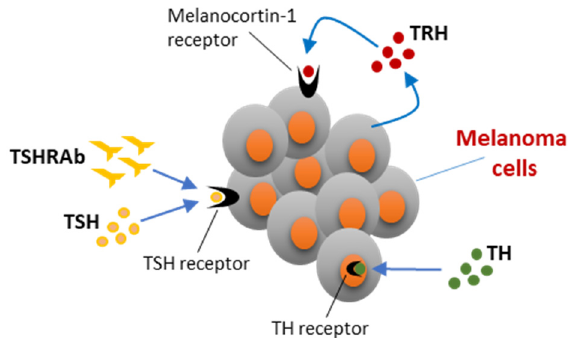
Figure 1. Schematic representation of the action of the different hormonal players of the hypothalamic–pituitary–thyroid axis on melanoma cells. TRH, thyrotropin-releasing hormone; TSH, thyroid stimulating hormone; TSHRAb, TSHR autoantibodies; TH, thyroid hormones. See description in the text.